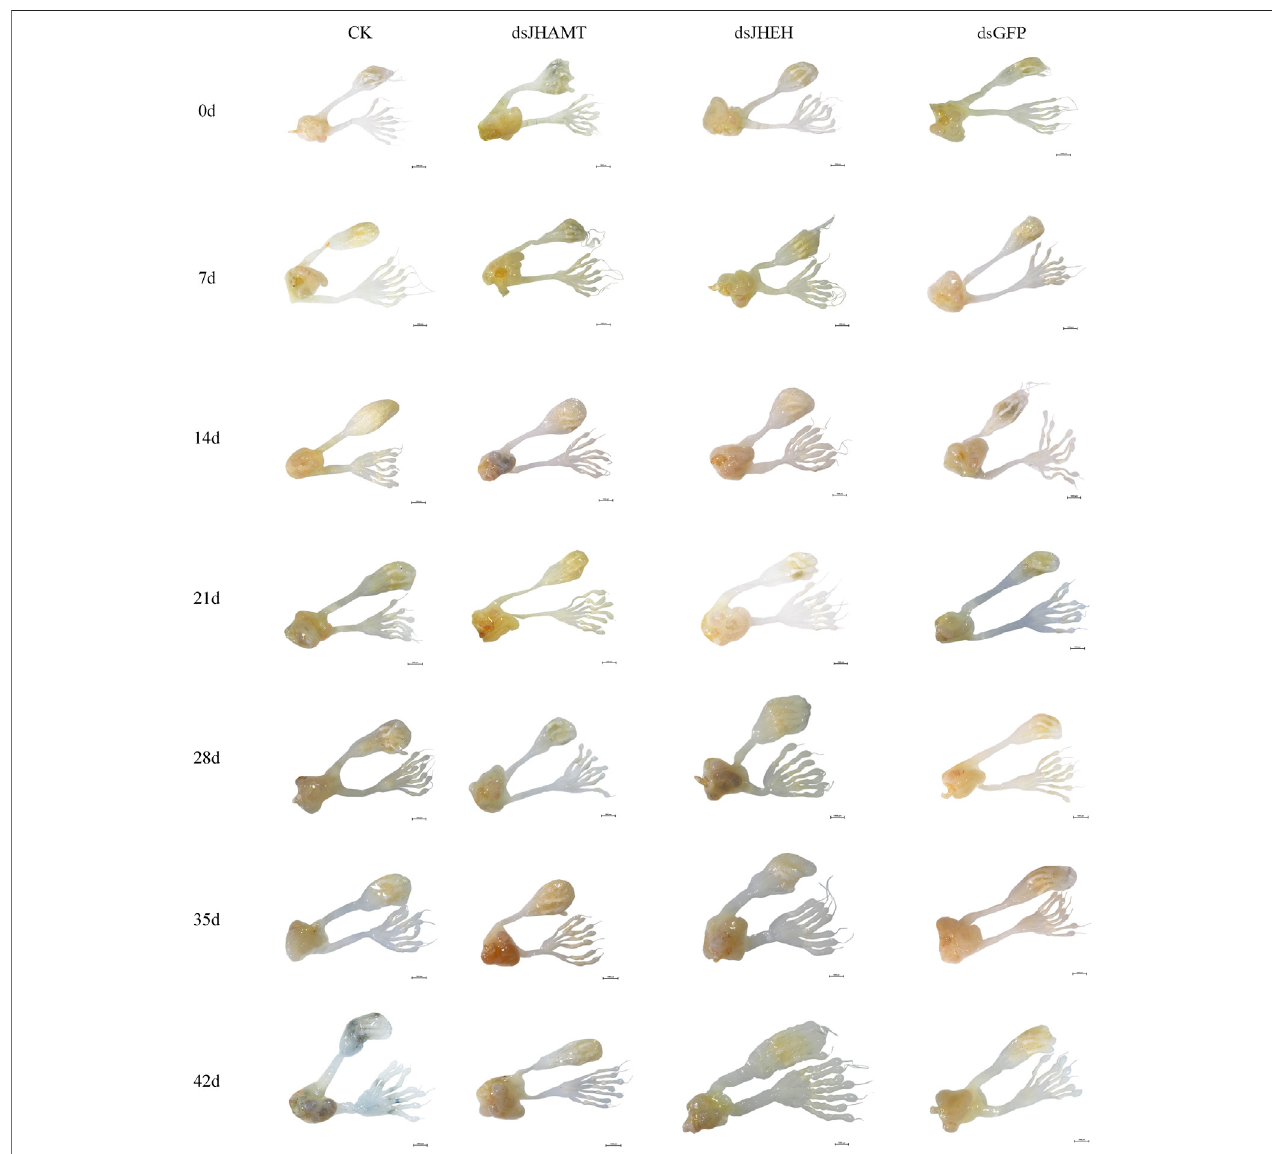
FIGURE 6 | Development pattern of male reproductive system after A. chinensis injected with